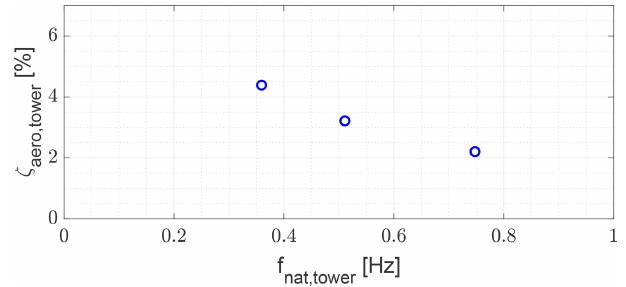
Figure 15. Dependency of aerodynamic damping on tower natural frequency for W = 15ms − 1